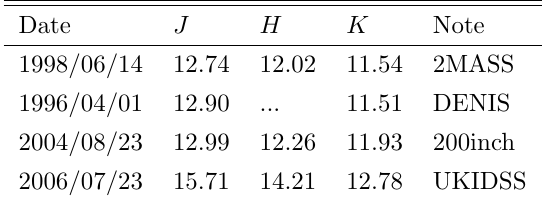
Table 3: Near Infrared